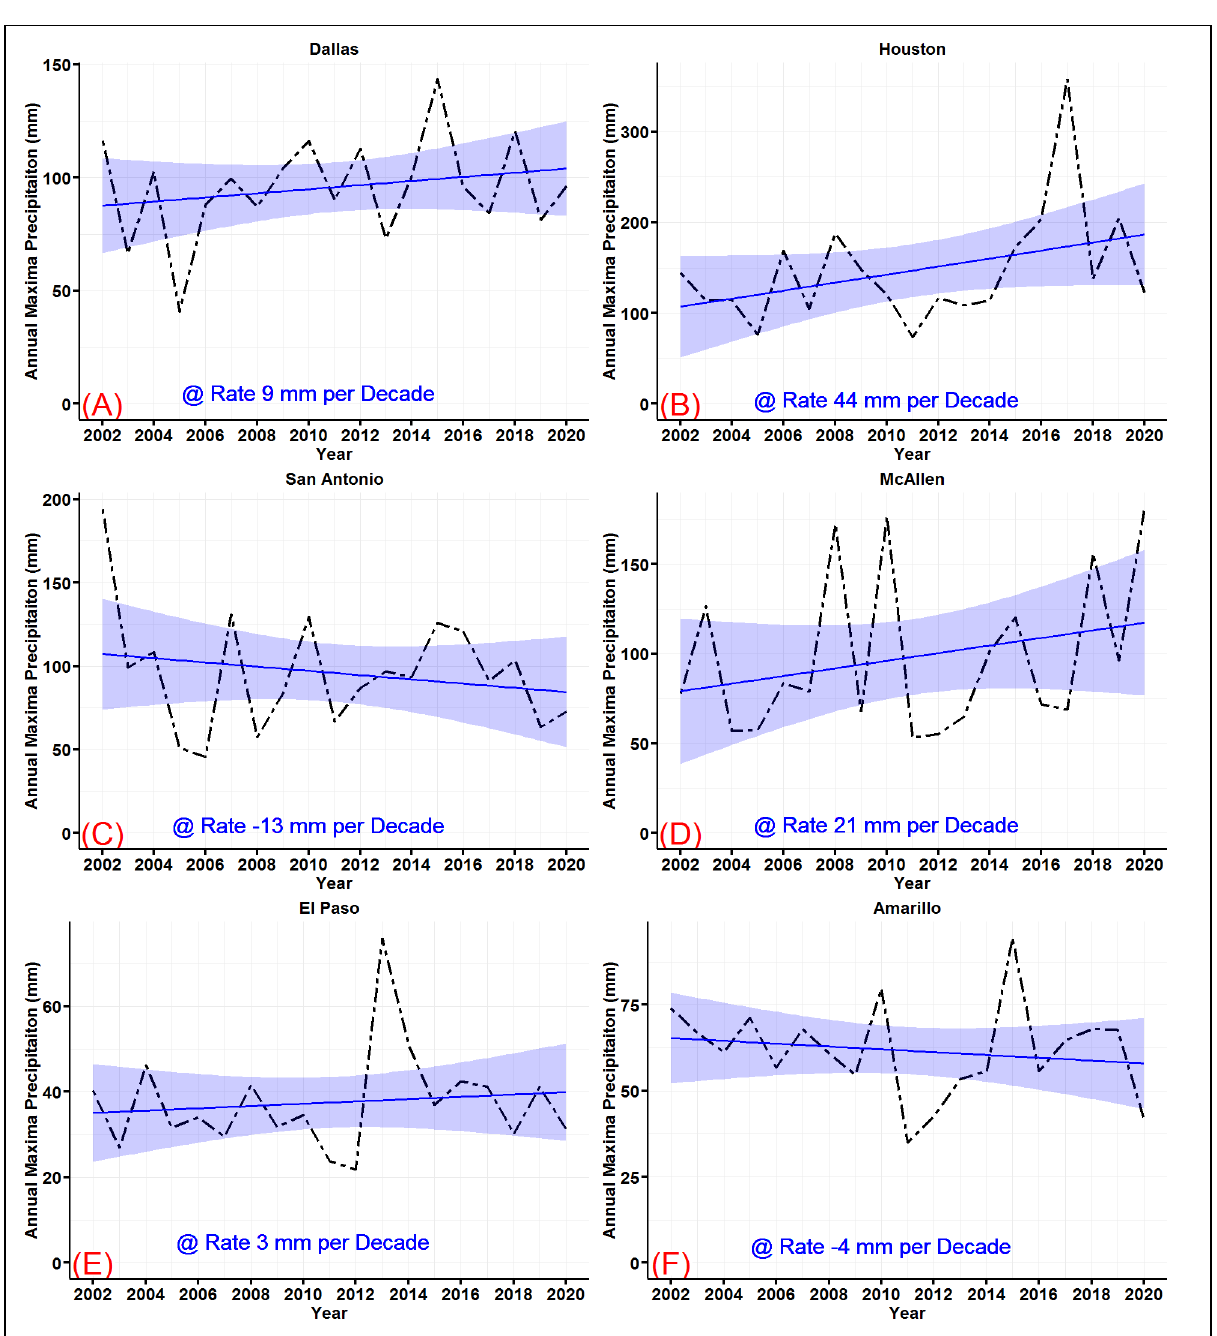
Figure 4. Temporal distribution of the 24-h duration storm with trendlines (blue) across the main metropolitan areas of ( A ) Dallas-Fortworth, ( B ) Houston, ( C ) San Antonio, ( D ) McAllen, ( E ) El Paso, and ( F ) Amarillo (shading represents the 95% confidence interval of the trendline using t-distribution).